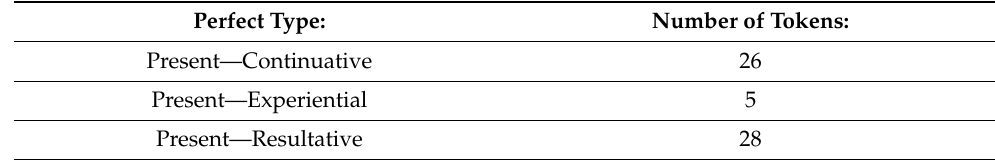
Figure 4. Distribution of Breton past forms in corpus B (dialogue with weak narration). Table 1. Breakdown of perfect and PRS.PRF types in English, in corpus